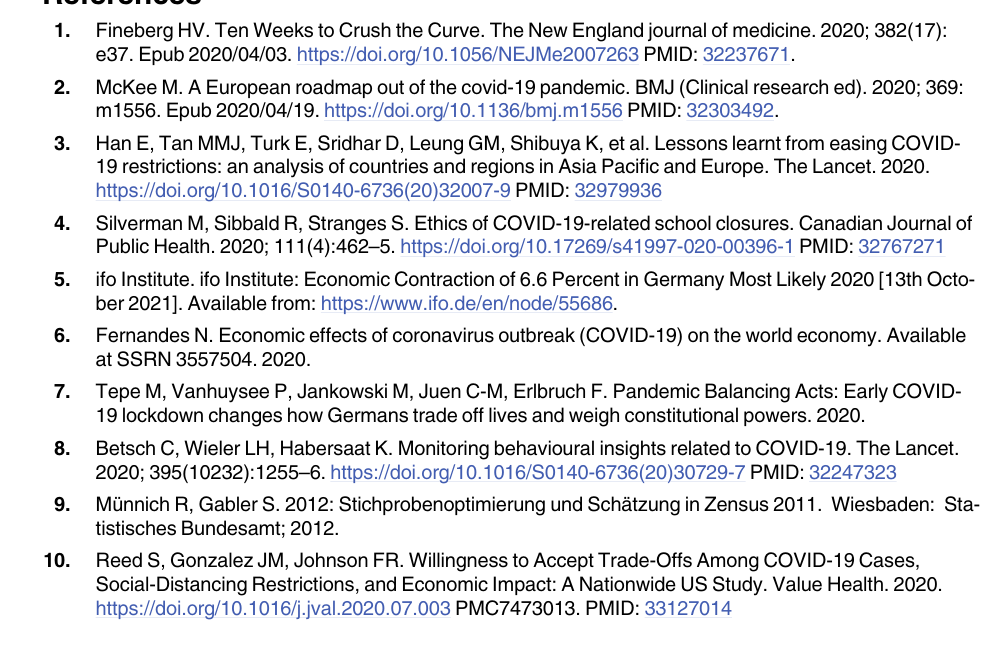
S1 Table. Affect: COVID-19